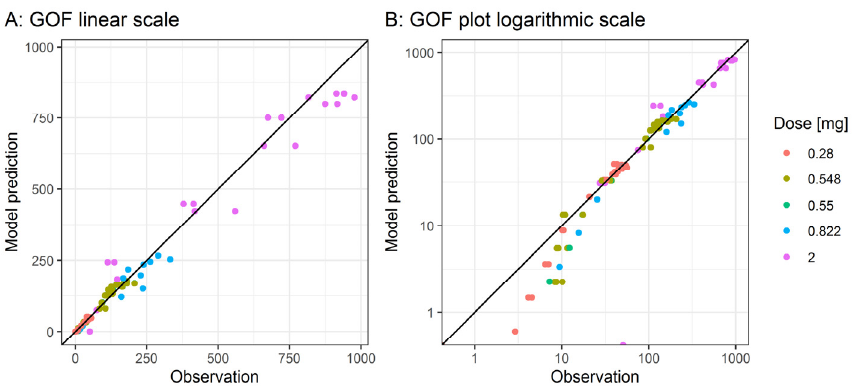
Figure A3. Goodness ‐ of ‐ fit (GOF) plots for PK model A showing predicted vs. observed azelastine plasma concentrations on linear scale ( A ) and log ‐ log scale ( B ). Black lines indicate the lines of iden ‐ tity. Table A2. Parameter estimates of the azelastine PK model A. No inter ‐ individual variability (IIV) was estimated, as the mean curves of azelastine plasma concentrations could be described accu ‐ rately without additional IIV.